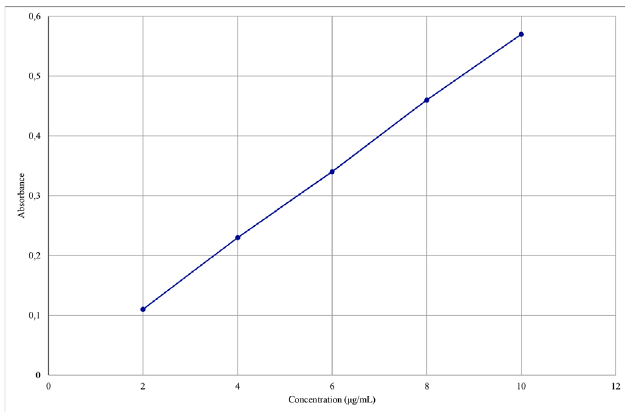
FIGURE 4 - Standard curve of